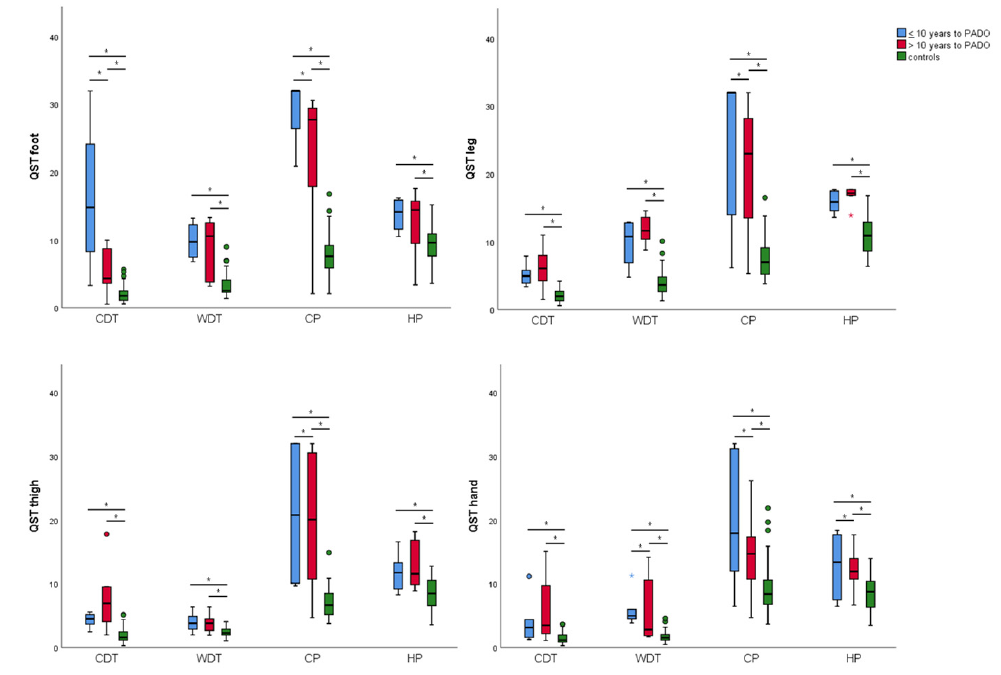
Figure 2. Comparison of QST finding between groups. Each panel represents a single stimulation site (foot, leg, thigh, hand). On the y -axis is reported the absolute temperature ( ◦ C) and on the x -axis is reported the different type of sensory stimulation (CDT = cold detection threshold; WDT = warm detection threshold; CP = cold pain; HP = heat pain). Different color denotes different group (in blue the group of patients with a time-to-PADO ≤ 10 years; in red the group of patients with a time-to-PADO > 10 years; in green the group of healthy controls). Asterisks (*) indicates significant p -value between groups ( p < 0.05).